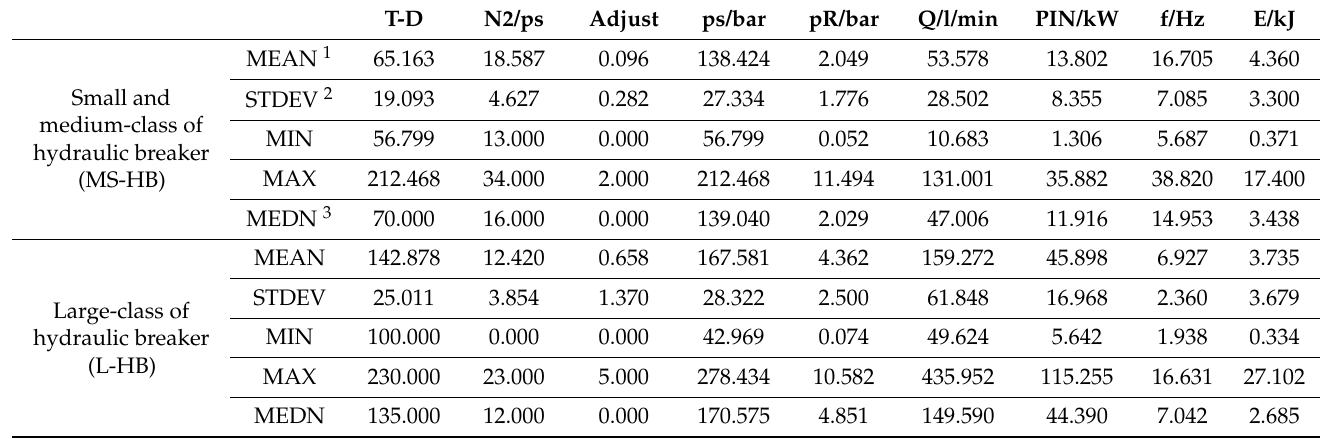
Table 3. Hydraulic breaker data